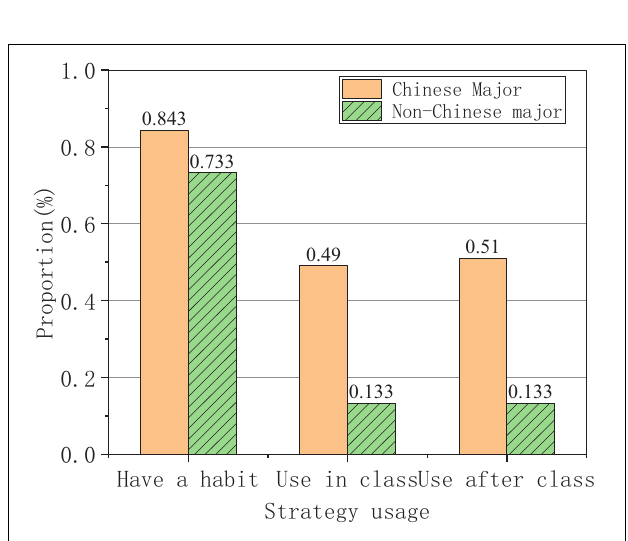
FIGURE 7 | The use of learning strategies for Chinese majors and non-Chinese majors.